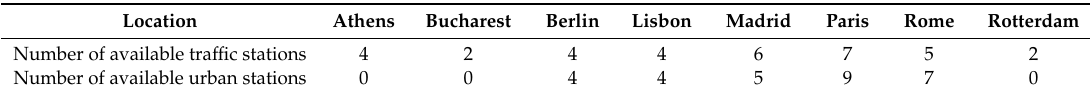
Table 2. Information about the type and number of available monitoring stations used in this study for the period 2005–2014.